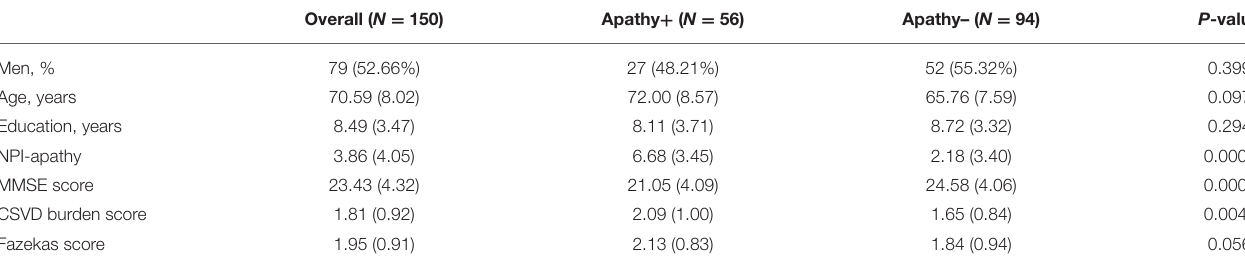
TABLE 1 | Clinical and demographic characteristics of the subjects with and without apathy.